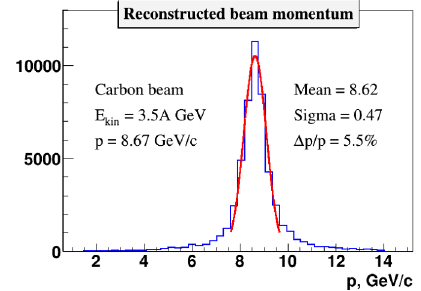
Figure 5. Carbon beam rigidity measured in the central